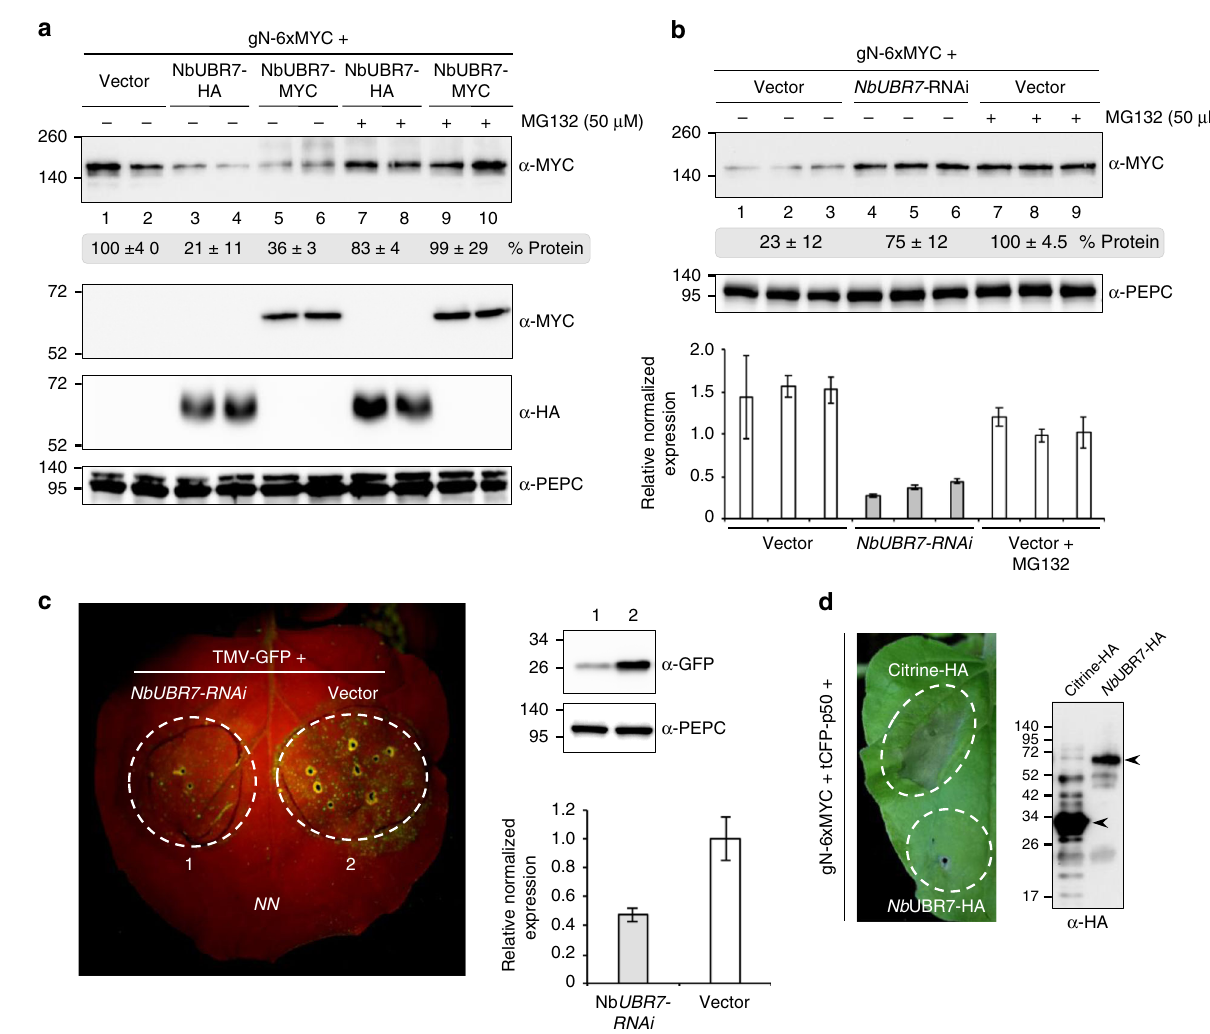
Fig. 5 NbUBR7 modulates N protein level and functions as a negative regulator of N -mediated defense. a Nb UBR7 overexpression reduced the stability of N in a proteasome-dependent manner. Agrobacterium containing expression sets consisting of an empty vector control (vector) or the agrobacterium containing the expression cassette of Nb UBR7-HA or Nb UBR7-MYC were in fi ltrated into N. benthamiana leaves followed by in fi ltration of MYC-tagged gN 24 later. 36 h after in fi ltration of gN, 50 µ M proteasome inhibitor MG132 ( + MG132) or the equal concentration of DMSO ( − MG132) were further in fi ltrated into the pre-in fi ltrated leaves. In fi ltrated leaf tissues were collected 12 h after DMSO or MG132 treatment and analyzed by western blot analysis. Antibodies used for the western blot analysis were indicated on the right of each panel. Equal protein loading is assessed by the similar amounts of PEPC protein. Molecular weight size markers in kDa are indicated on the left. Two independent samples ( n = 2) for each treatment were analyzed in parallel. Band intensity was measured by Image J software and normalized to the PEPC protein control. Numbers below the top panel indicate the relative quanti fi cation of the corresponding band intensity, of which the empty vector control group was set to 100% [ “ ± ” indicates standard deviation (SD) of the mean]. b Double stranded hairpin-mediated silencing of Nb UBR7 ( Nb UBR7-RNAi) enhances the stability of N. Empty vector control (vector) or the agrobacterium containing the hairpin Nb UBR7 were in fi ltrated into the N. benthamiana leaves followed by in fi ltration of MYC-tagged N at 24 hpi. 36 h later, DMSO (-MG132) or MG132 (MG132) was then in fi ltrated into the pre-in fi ltrated leaves as described above. In fi ltrated leaf tissues were collected 12 h after DMSO or MG132 treatment and analyzed by western blot. Three independent replicates ( n = 3) were carried out for each treatment. Numbers below the top panel indicate the relative quanti fi cation of the corresponding band intensity, of which the MG132-treated empty vector control was set to 100% ( “ ± ” indicates SD). Equal protein loading is assessed by the similar amounts of PEPC protein (middle panel). Molecular weight size markers in kDa are indicated on the left. The downregulation of Nb UBR7 in the in fi ltrated leaves were also con fi rmed by RT-qPCR (bottom panel). Data from three biological replicates were combined and values are shown as mean ± SD. c RNAi of Nb UBR7 enhances the N -mediated resistance to TMV. Different regions of the leaf of N - containing transgenic N. benthamiana were fi rst agroin fi ltrated with hairpin Nb UBR7 (1) and the control empty vector (2), respectively. 24 h later, TMV-U1- GFP was agroin fi ltrated into the previously in fi ltrated regions. Photographs were taken under UV light at 5 dpi and representative results are shown (left panel). Leaf samples from the region 1 and 2 were then harvested and subjected to western blot analysis using the antibodies against GFP or PEPC (top right panels). RT-qPCR was performed to con fi rm the downregulation of Nb UBR7 in the in fi ltrated region of the leaves (bottom right panel). Data from three biological replicates were combined and values are shown as mean ± SD. d Overexpression of Nb UBR7 inhibits p50 effector-induced HR-PCD. Different leaf regions were in fi ltrated with MYC-tagged N (gN-6xMYC), TagCFP-tagged p50 (tCFP-p50) together with HA-tagged Nb UBR7 ( Nb UBR7-HA) or citrine (Citrine-HA) control. Photographs were taken at 6 dpi and representative results are shown (left panel). The expression of citrine-HA or Nb UBR7-HA was con fi rmed by Western blot analysis using anti-HA antibody (right panel). Arrowheads indicate the speci fi c band of different HA fusions. Source data are provided as a Source Data fi